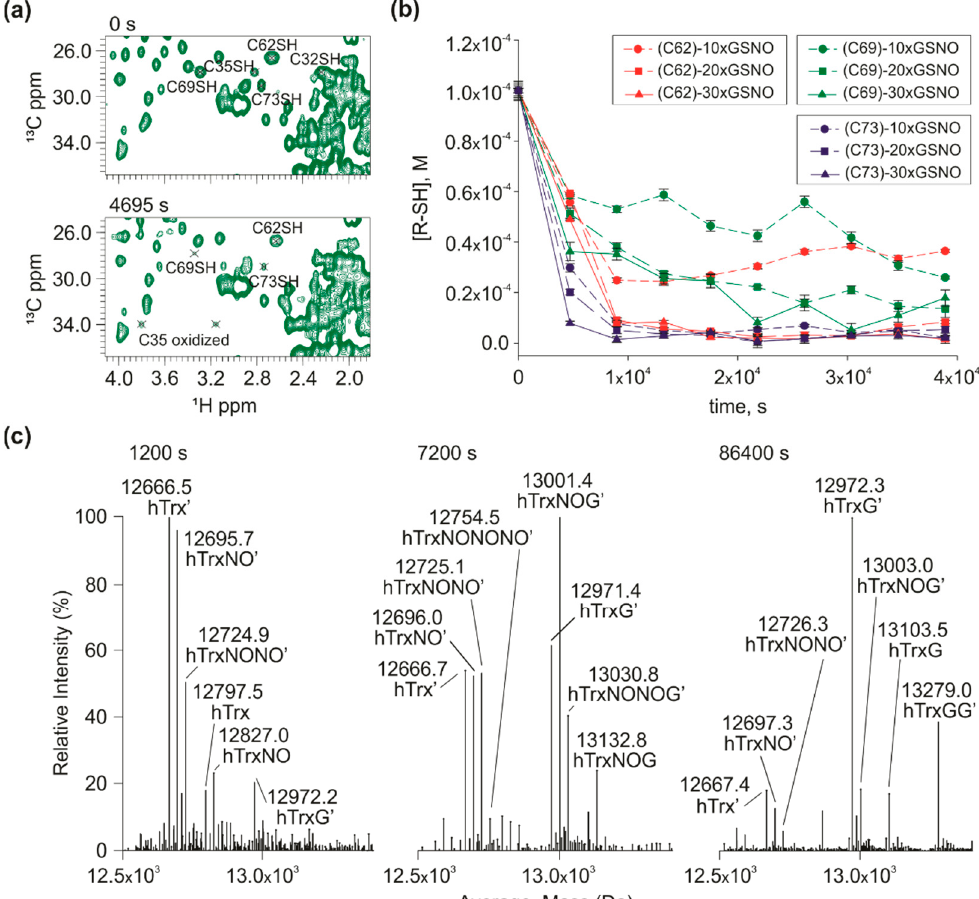
Figure 3. S-nitrosation kinetics of wild type hTrx: ( a ) 1 H- 13 C HSQCs acquired before (0 s) and after (4695 s) the addition of 10× excess of GSNO. In the upper zoom, it is possible to observe the cross- peak H β /C β of the non-nitrosated residues C32, C35, C62, C69, and C73. After 4695 s, only the signals of residues C62, C69, and C73 can be observed. The signals of C32 and C35 do not appear in the spectrum in their reduced forms, after the addition of GSNO. It is possible to observe only the oxidized C35; ( b ) The red, green, and blue curves correspond to the S-nitrosation kinetics of cysteines C62, C69, and C73, respectively, with an excess of 10×, 20×, and 30× GSNO. The concentration of each non-nitrous cysteine residue was monitored over time. C73 is the most reactive residue, as it showed the greatest decay; ( c ) Mass spectra were acquired after the addition of an excess of 10x of GSNO at three different reaction times: 1200 s, 7200 s, and 86,400 s. At 1200 s, we observed the formation of the doubly S-nitrosated species hTrx’.NO.NO and mono glutathionylated hTrx’, in addition to the presence of the species mono S-nitrosated (hTrx.NO and hTrx’.NO.G. After 7200 s of reaction it was possible to observe the same protein accumulating three modifications, two S- nitrosation s plus one S-glutathionylation (hTrx’.NO.NO.G) and three S-nitrosation s at the same time (hTrx’.NO.NO.NO). After 86,400 s of reaction the major peaks in the spectra are equivalent to a protein mono and doubly S-glutathionylated, hTrx’.G and hTrx’.G.G, respectively. The experimental error for each experimental point in B was estimated from the standard deviation of the spectral noise for one experiment. A remarkable finding was that rate of disappearance of reduced resonance of C69 and C73 was much slower than that observed for C69only and C73only. For C73, compare the curves of 10× GSNO of the wild-type (Figure 3) and C73only (Figure S2). For C69, compare the curves of 10×, 20× and 30× of GSNO of the wild-type (Figure 3) and C69only (Figure S1). On the other hand, the cross-peaks of the reduced C62 decayed much faster than the C62only mutant (Figure 3B). These data suggest that there is an interdependence among the nitrosative cysteines in hTrx. To better understand this phenomenon, we constructed mutants containing two and three cysteines of the nitrosative site: C62/C69